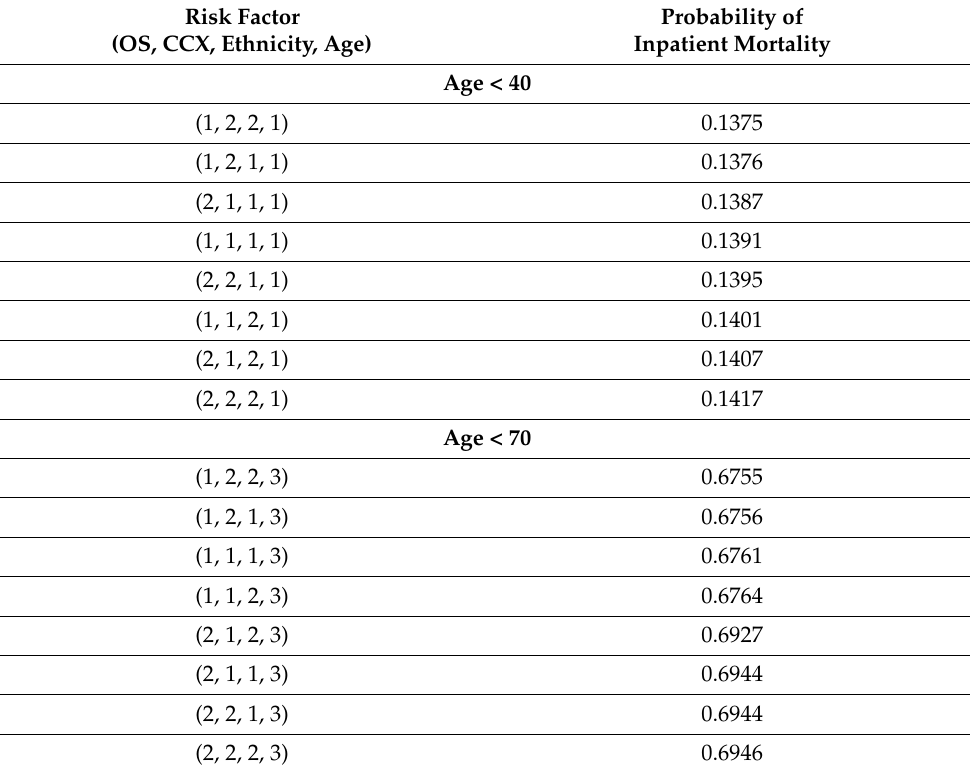
Table 4. The conditional probability of IPD given different configurations of OS, Ethnicity, CCX and Age. Risk Factor Probability of (OS, CCX, Ethnicity, Age) Inpatient Mortality Age < 40